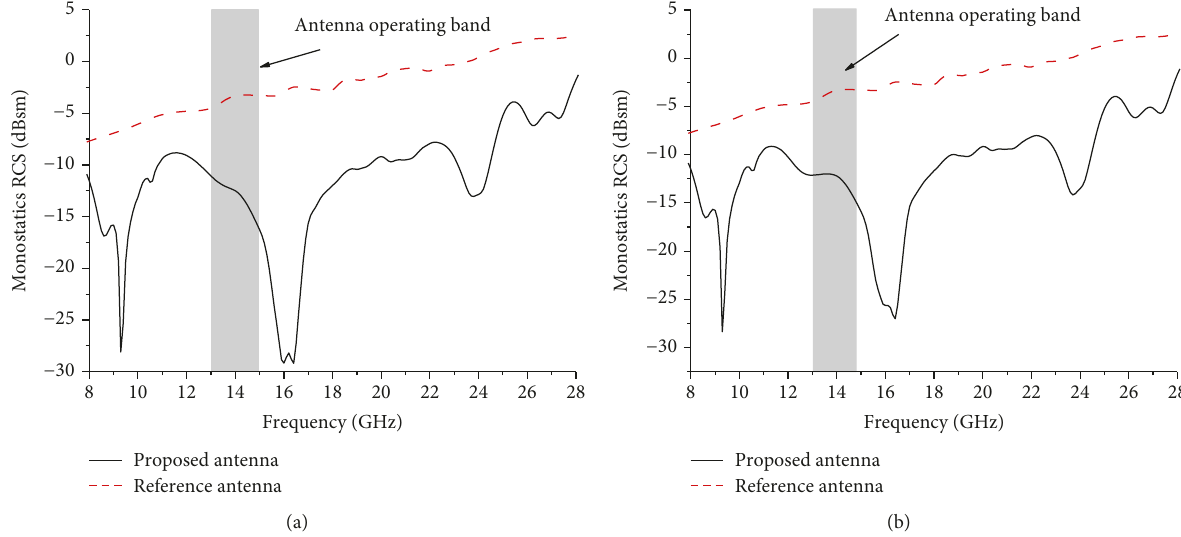
Figure 12: Monostatic RCS of the proposed and reference antennas for normal incidence: (a) x -polarized incidence; (b) y -polarized